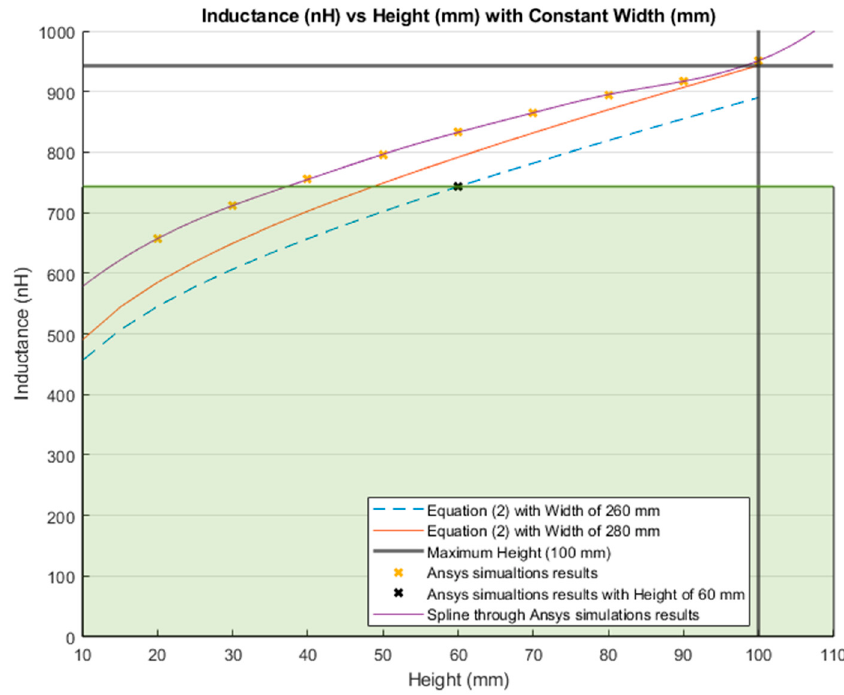
Figure 24. Inductance calculation with a constant width (mm) and a variable height (mm). High- lighted in green shading is 78.79% of the total inductance change.